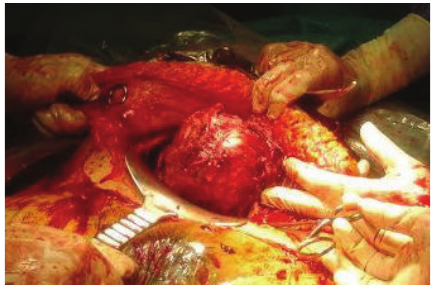
Figure 1: Large intramural leiomyoma protruding from the anterior lower segment (after dissection of anterior pseudocapsule).